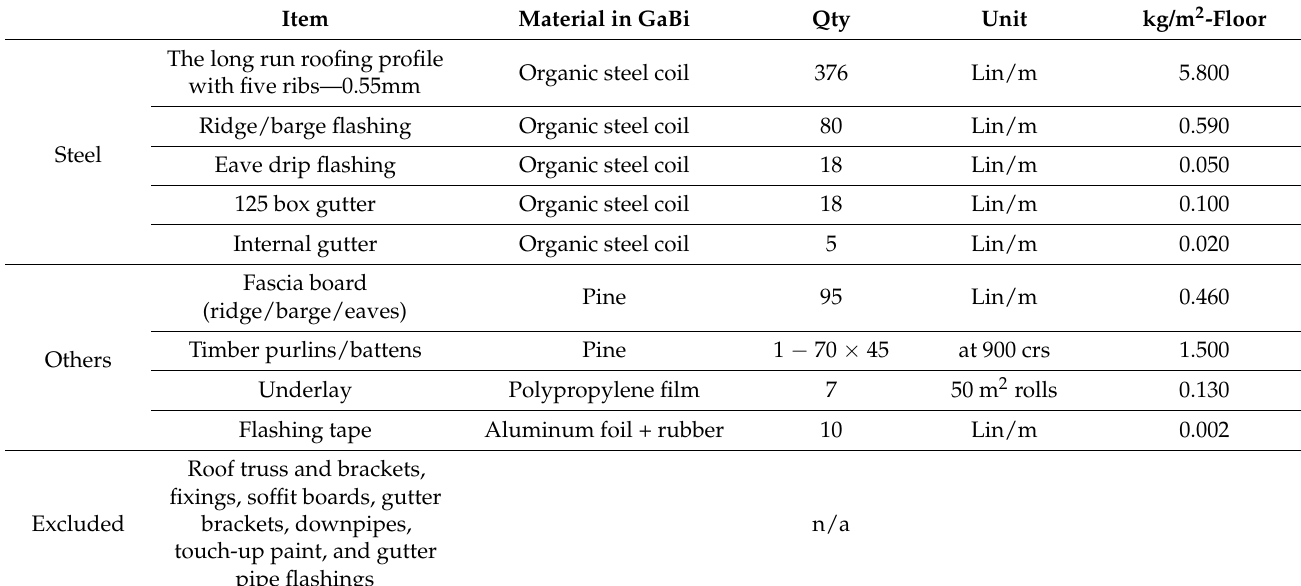
Table 1. Bill of materials for case study